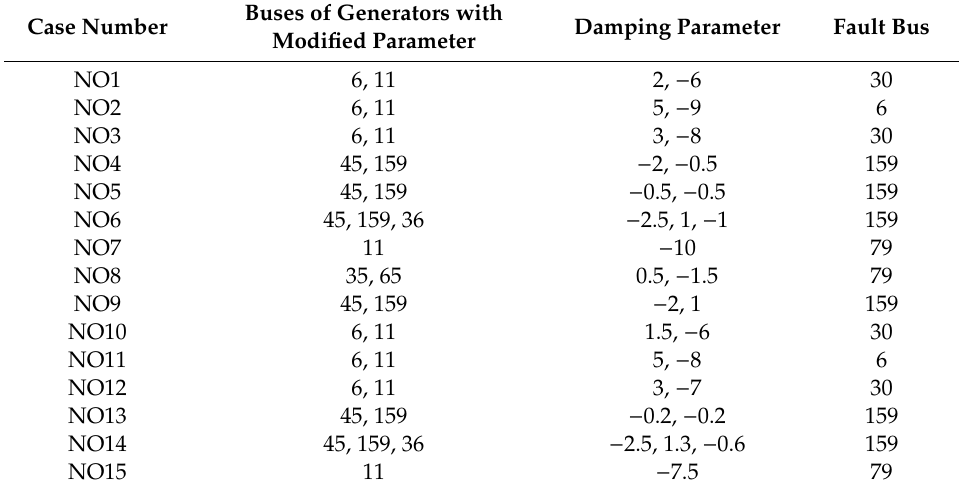
Table 3. Cases of natural oscillations.